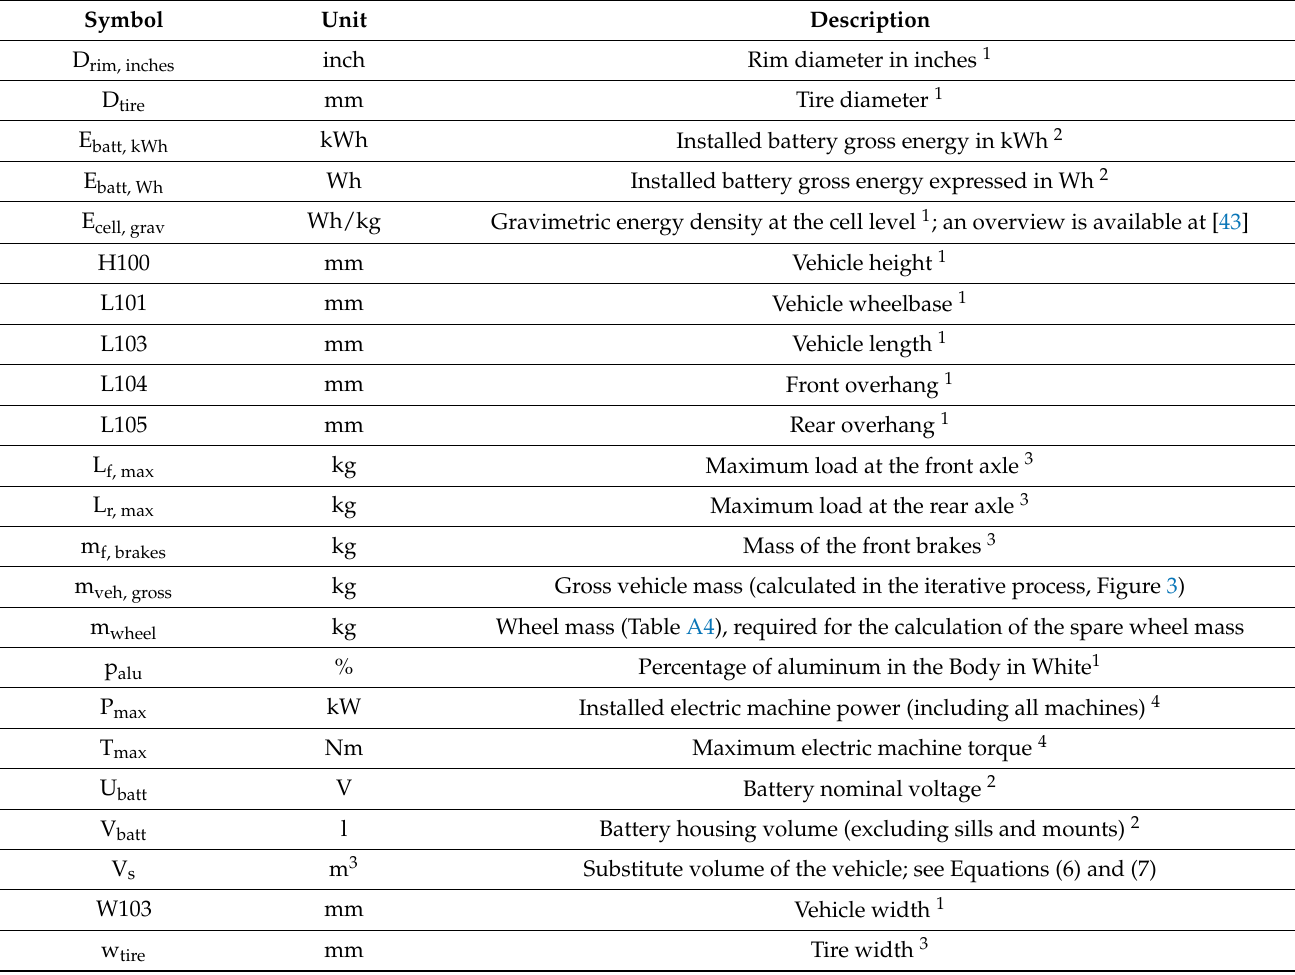
Table A2. List of symbols employed in Tables